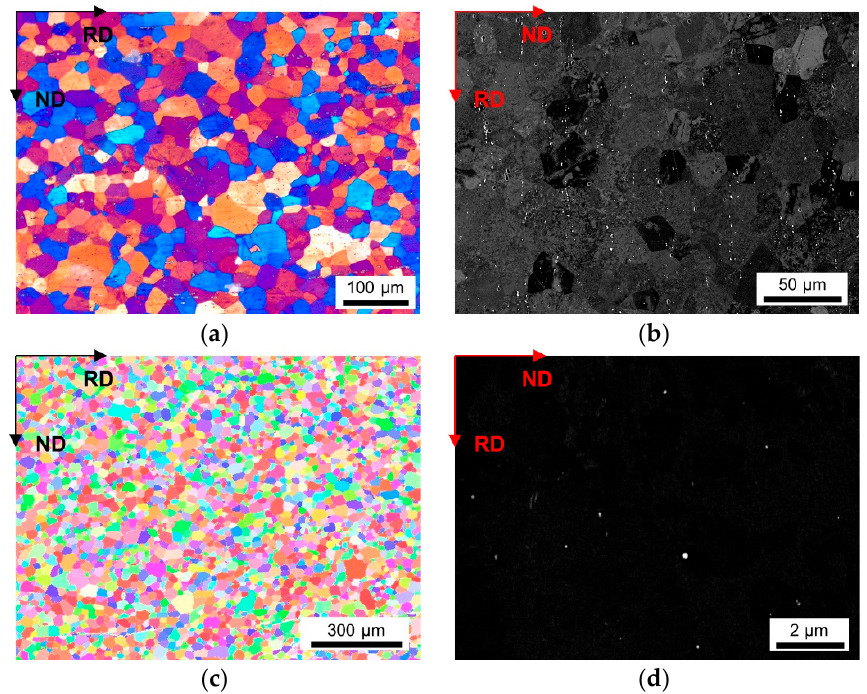
Figure A3. Microstructure of the soft annealed LFe-LMn cast under NR-C condition, homogenized at 500 °C and cold rolled to a CRD of 63%. ( a ) LOM. ( b ) BSE image. ( c ) EBSD IPF map in RD–ND plane. ( d ) BSE micrograph showing dispersoids.